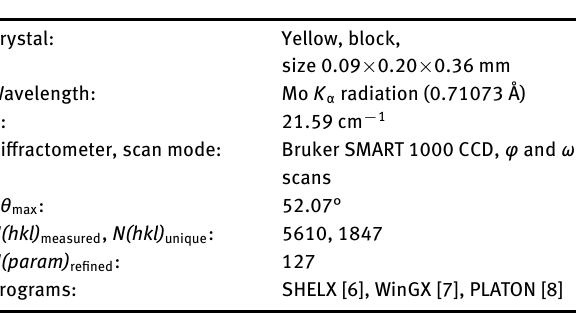
Table 1: Data collection and handling.